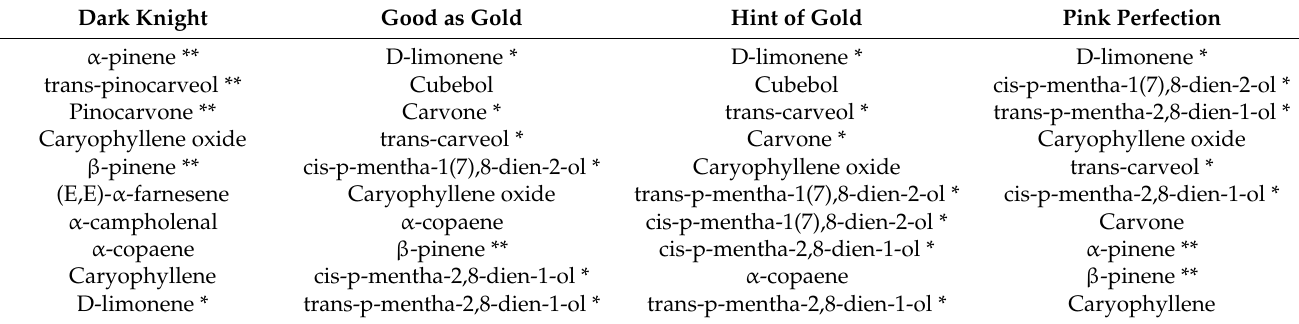
Table 1. Ten main volatile compounds of four Caryopteris x clandonensis cultivars, visible between the cultivars were selected and are hierarchically listed (top: higher concentration, bottom: lower concentration). GC-MS Headspace was performed and an identification with a NIST/EPA/NIH MS library version 2.0 was conducted. * represents limonene-related terpenoids. ** represents pinene-related